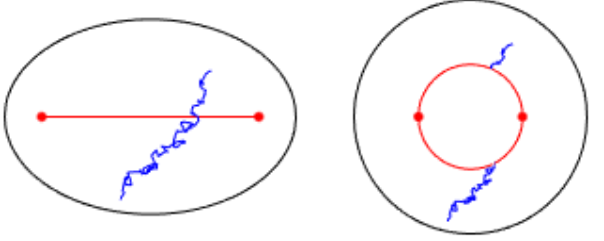
Figure 3. The transformation (9) maps the Browian paths crossing the focal segment in E into discontinuous paths in the circular